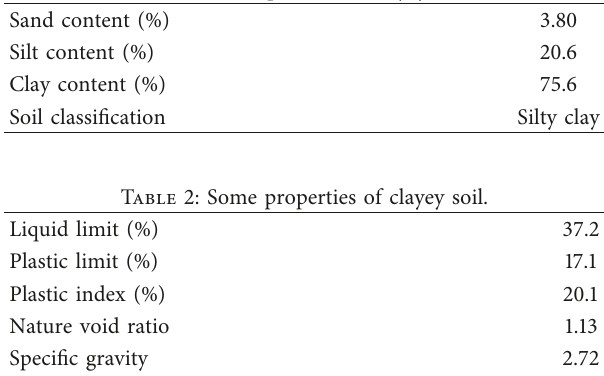
Figure 1: Test materials. (a) Clayey soil. (b) Scrap tire crumbs. Table 1: Components of clayey soil.